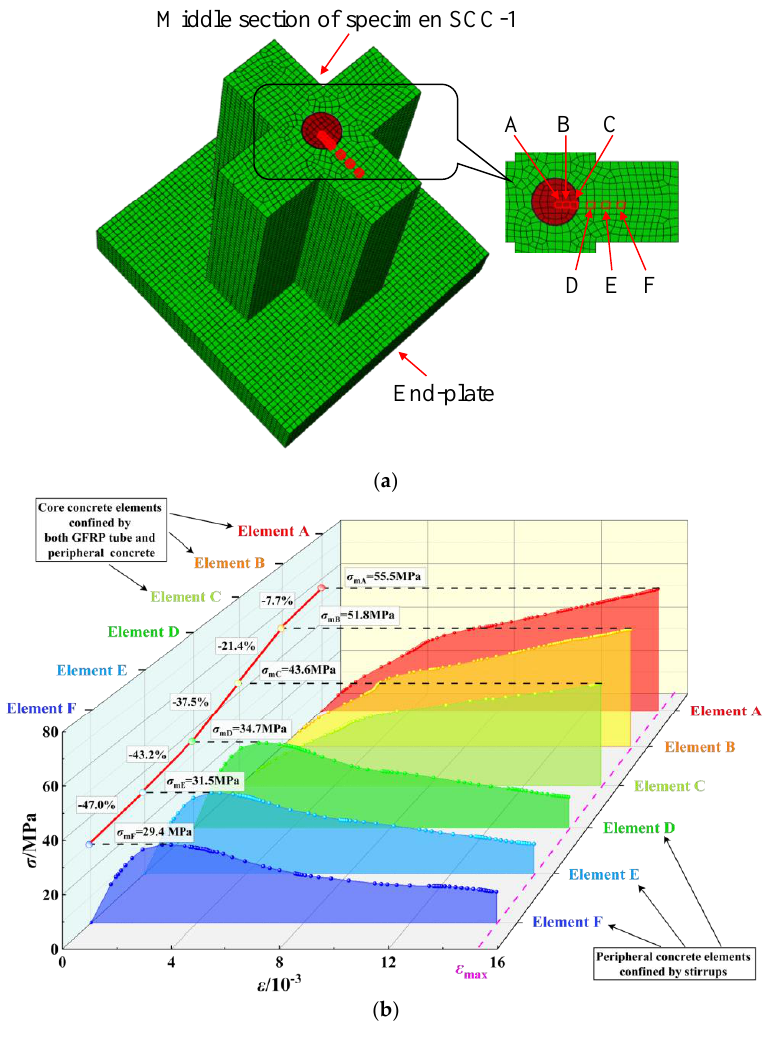
Figure 20. Stress – strain curves of concrete elements at the middle section of specimen SSC-1: ( a ) distribution of concrete elements; ( b ) stress – strain curves of elements A, B, C, D, E and F.